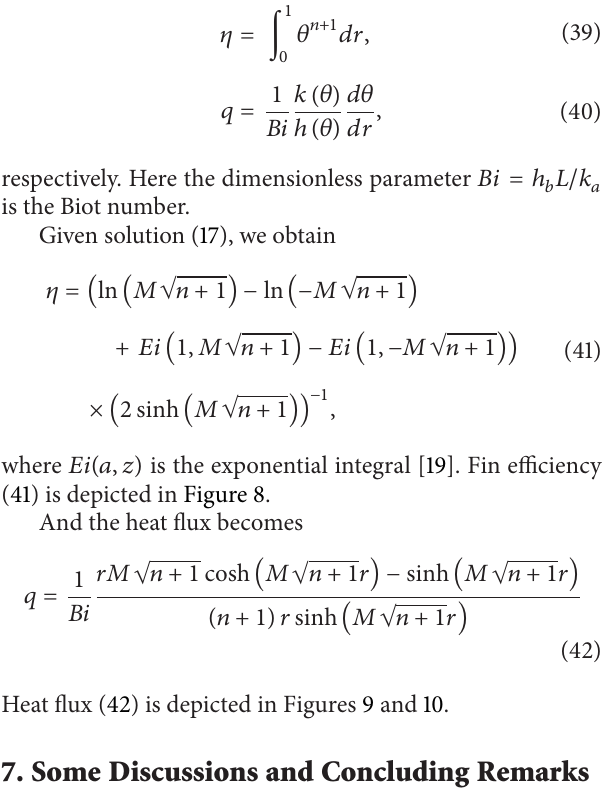
Figure 8: Fin efficiency for varying values of 𝑛 .